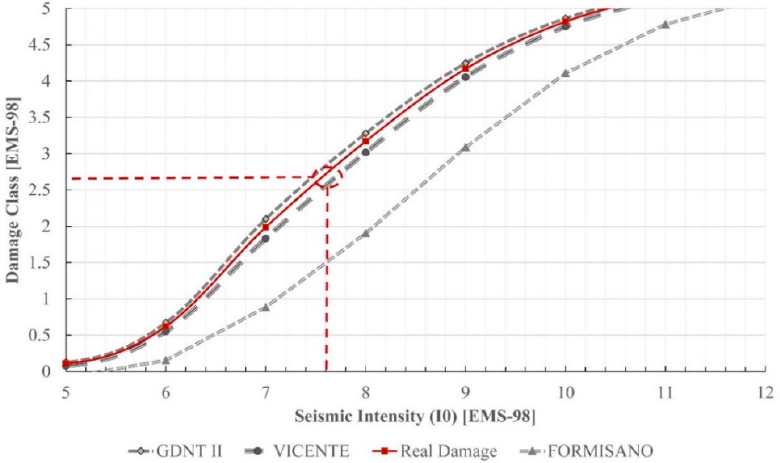
Figure 16. Vulnerability curves of the case study for different seismic intensities using the I V methods selected; the damage and the intensity of the seismic events of October 2016 are highlighted in red, through the damage detected after the seismic emergency. Starting from the latter, the real damage is extended to other seismic intensities through the Bernardini et al. (2007) formulation [31].